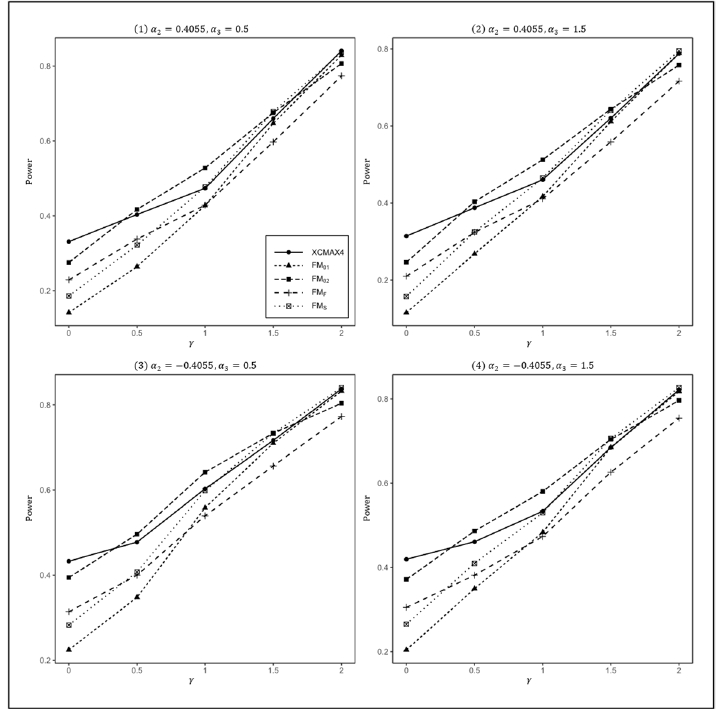
Figure 3. Estimated powers of XCMAX4, FM 01 , FM 02 , FM F , and FM S under various XCI models. The simulation was based on 10,000 replicates with β = 0.15, α 1 = − 5, F = 0, q f = 0.2, and q m = 0.3 .